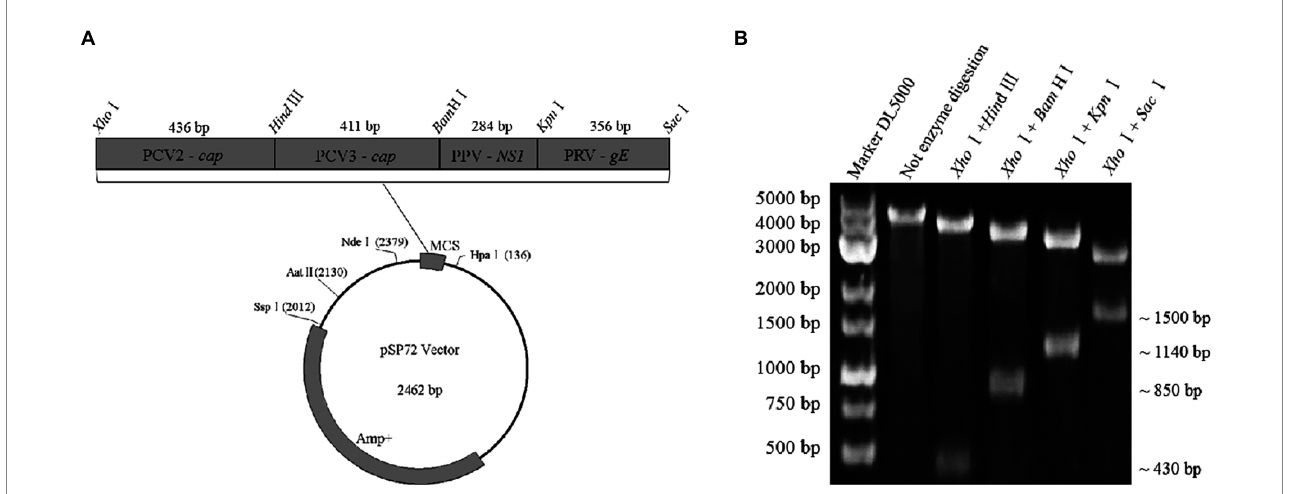
FIGURE 2 Construction and identification of a recombinant plasmid contains four genes in tandem. (A) Representative diagram of recombinant plasmid. (B) Restriction digestion assays of recombinant plasmid: ~430 bp in size specific for the cap gene of PCV2, ~850 bp in size specific for the two gene fragments (PCV2 cap and PCV3 cap ) in tandem, ~1,140 bp in size specific for the three gene fragments (PCV2 cap , PCV3 cap , and PPV NS1 ) in tandem, ~1,500 bp in size specific for the four gene fragments (PCV2 cap , PCV3 cap , PPV NS1 , and PRV gE ) in tandem were identified by digestion